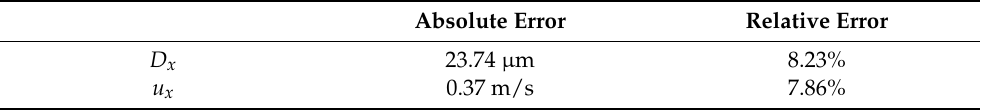
Figure 15. Absolute errors between the measured and theoretical data corresponding to the droplet velocity: ( a ) different spray angles; and ( b ) different flow rates. Table 6. Errors of measured and theoretical data.